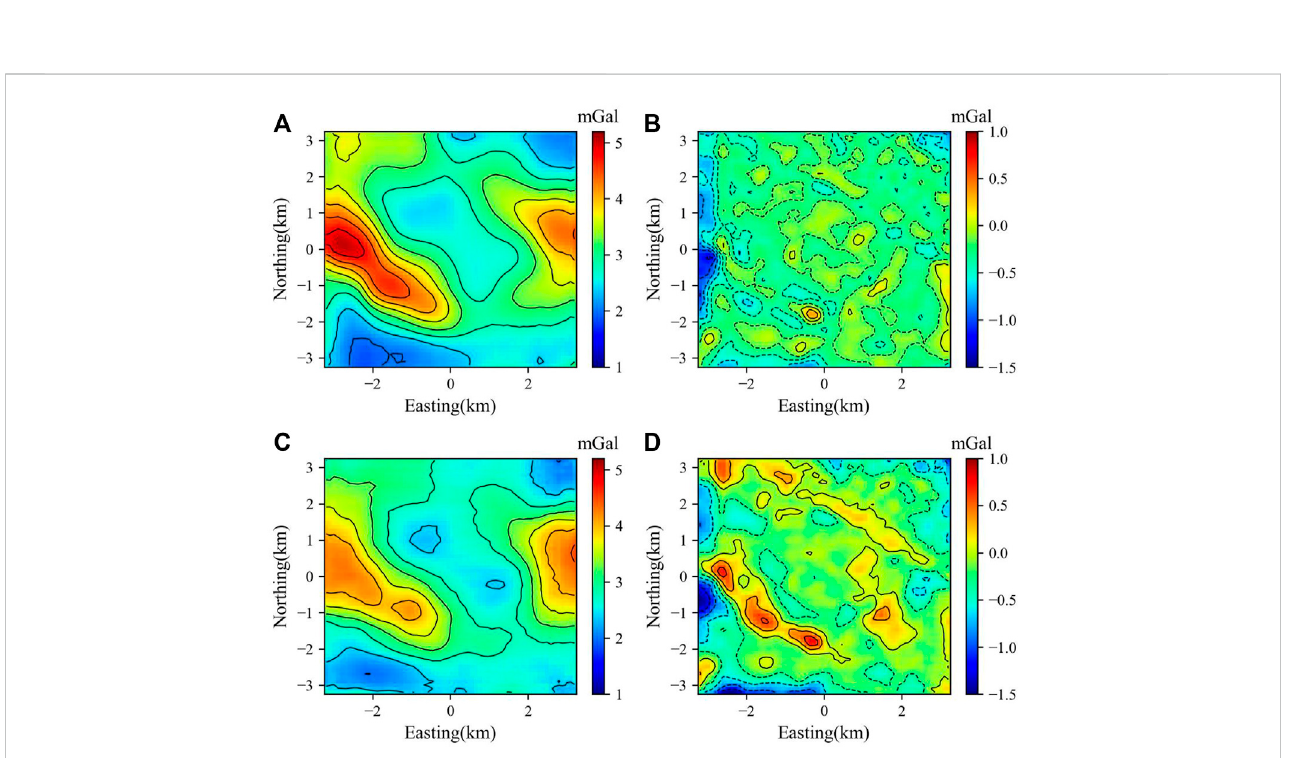
FIGURE 9 (A) GravityanomalyatthegeoidpredictedbytheNFDC-Netmodel. (B) Errorbetween (A) andFigure8A. (C) Gravityanomalyatthegeoidpredictedbythe DC-Net model. (D) Error between (C) and Figure